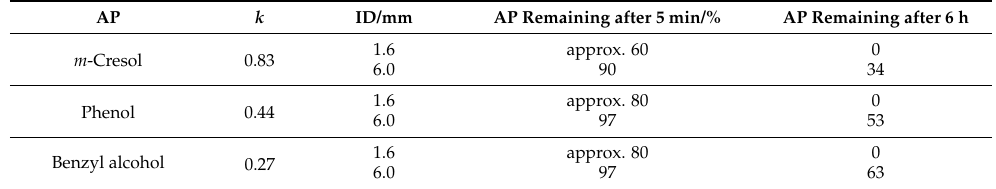
Table 10. Loss of antimicrobial preservatives (AP) from silicone tubing with an inner diameter (ID) of 1.6 mm and 6.0 mm. The partition coefficient ( k ) of each preservative was calculated. The percentage of remaining preservative in solutions were determined after incubation for 5 min and 6 h [117]. AP k ID/mm AP Remaining after 5 min/% AP Remaining after 6 h 1.6 approx. 60 0 m -Cresol 0.83 6.0 90 34 1.6 approx. 80 0 Phenol 0.44 6.0 97 53 Benzyl alcohol 0.27 1.6 approx. 80 97